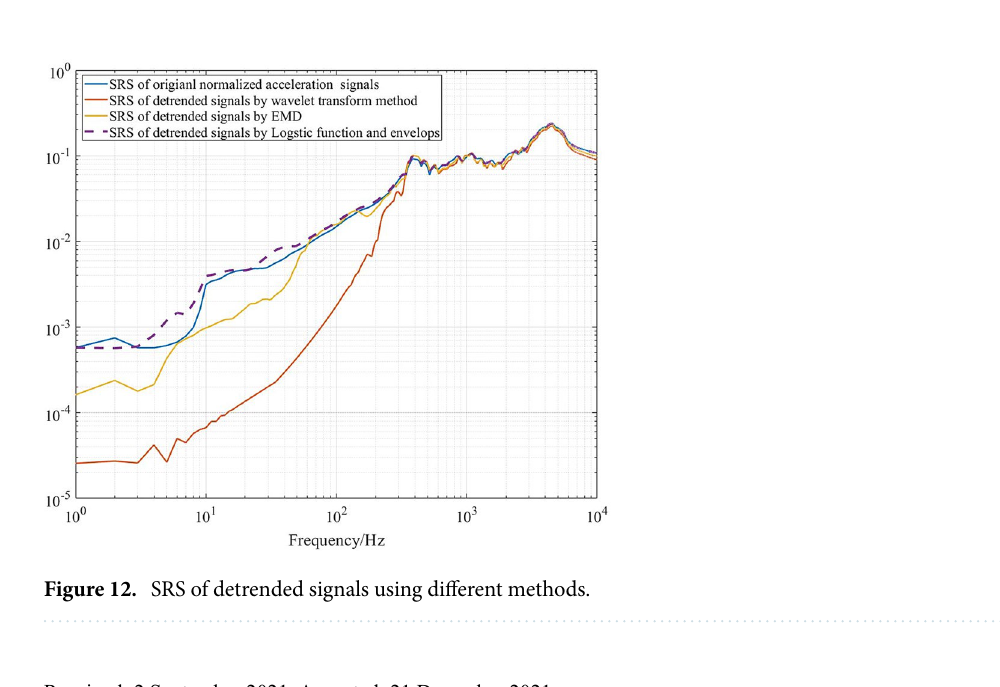
Figure 11. Extracted trends using different methods.